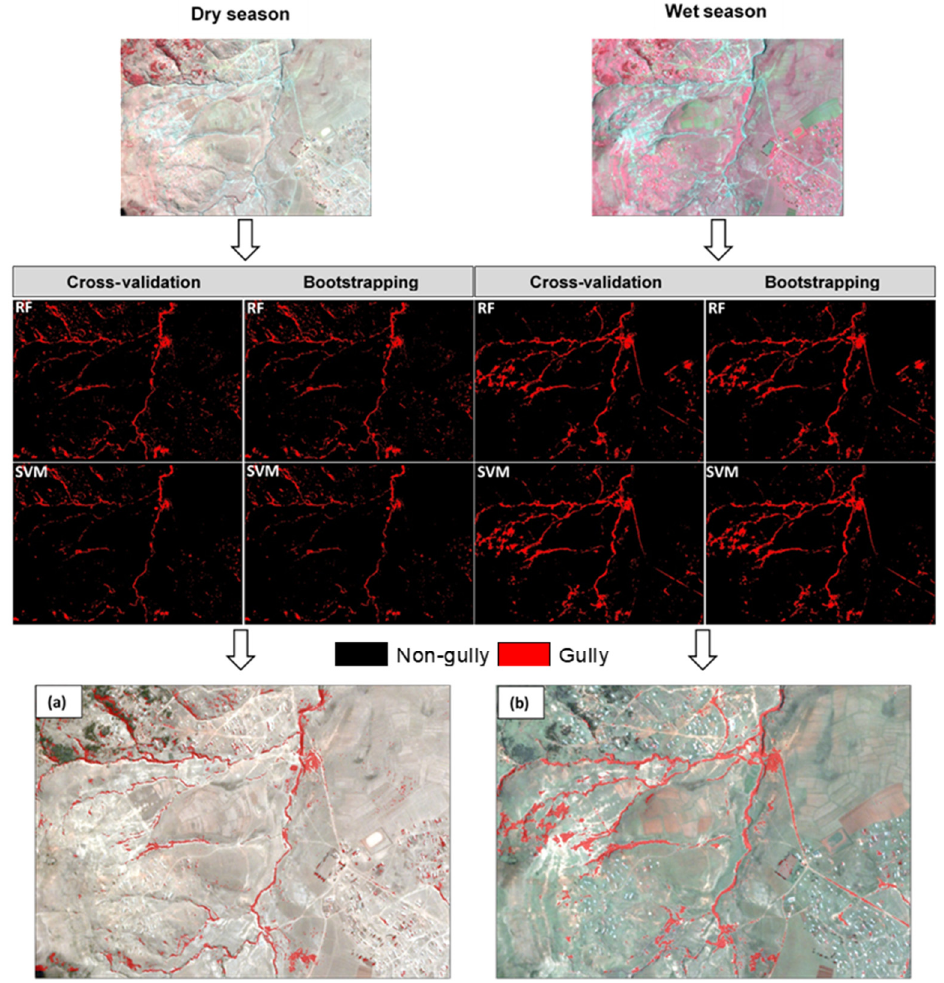
Figure 7. Spatial distribution of gullies: ( a ) rf-d-b and ( b ) svm-w-cv correspond to the best models for gully mapping in the dry and wet seasons, respectively (rf: random forest, svm: support vector machine, w: wet season, d: dry season, cv: cross-validation, b: bootstrapping).